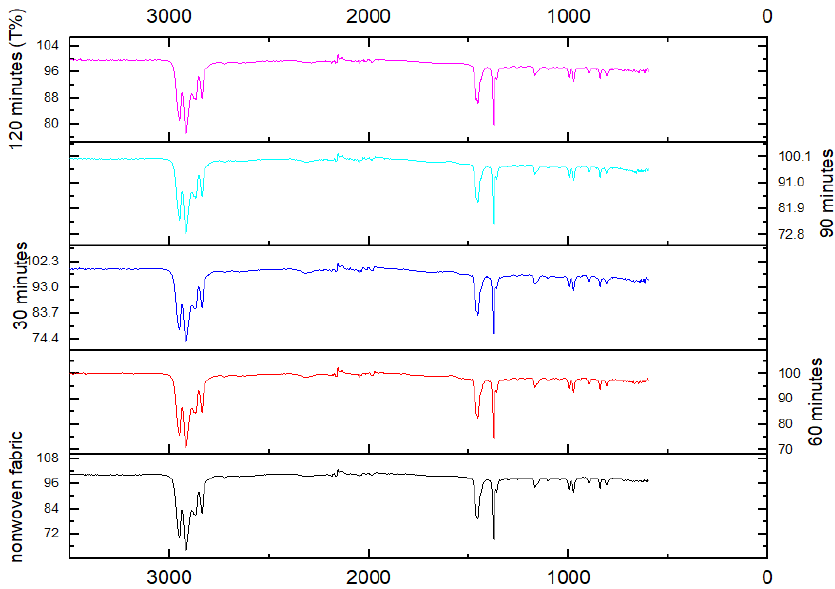
Figure 10. FTIR spectra of PLA - 19/C4 samples at different electrospinning times.